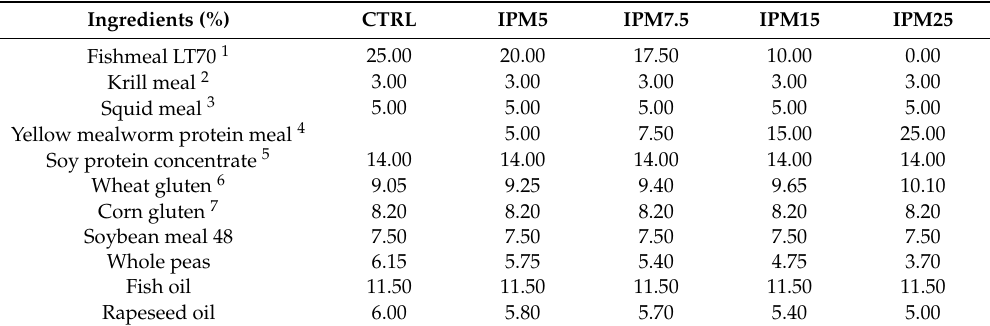
Table 1. Formulation and proximate composition of the experimental diets (Control: CTRL, and test diets with 5%, 7.5%, 15%, or 25% insect protein meal (IPM), respectively IPM5, IPM7.5, IPM15, and